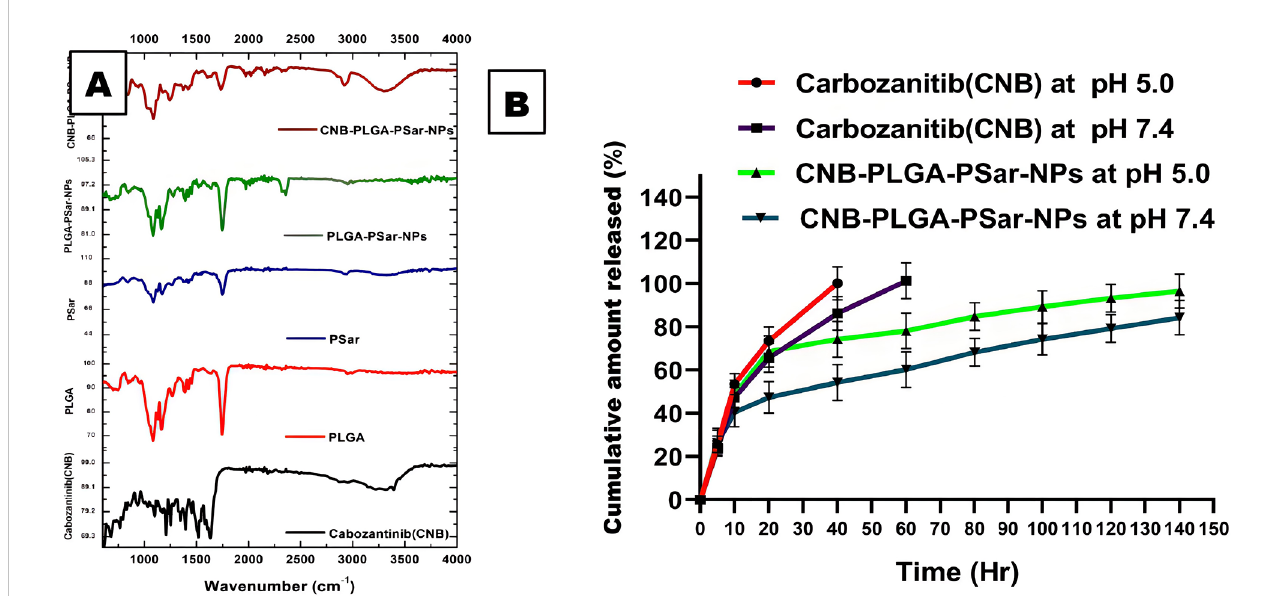
FIGURE 2 (A) FTIR data of Cabozantinib (CNB), PLGA, PSar, PLGA-PSar-NPs, CNB-PLGA-PSar-NPs. (B) In vitro release kinetics of CNB from CNB-PLGA-PSar-NPs in PBS at pH 5.0 and 7.4 and data are presented as mean ± SD (n=